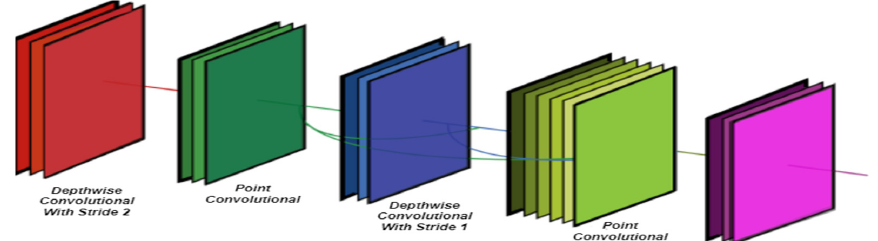
Figure 6. A visual diagram of the architecture of MobileNet.